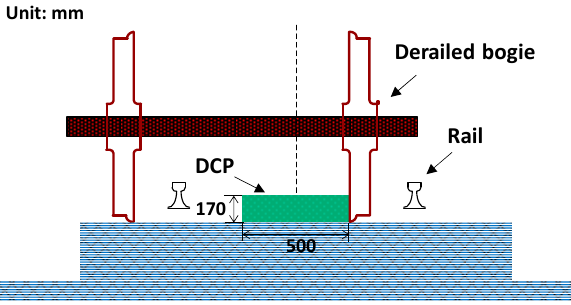
Figure 1. Overview of the derailment-containment prevention (DCP) wall developed in Korea [1].